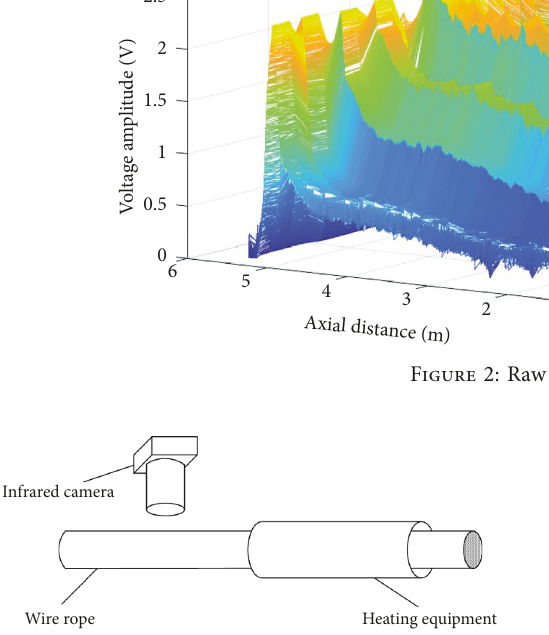
Figure 3: Schematic diagram of infrared image acquisition device.